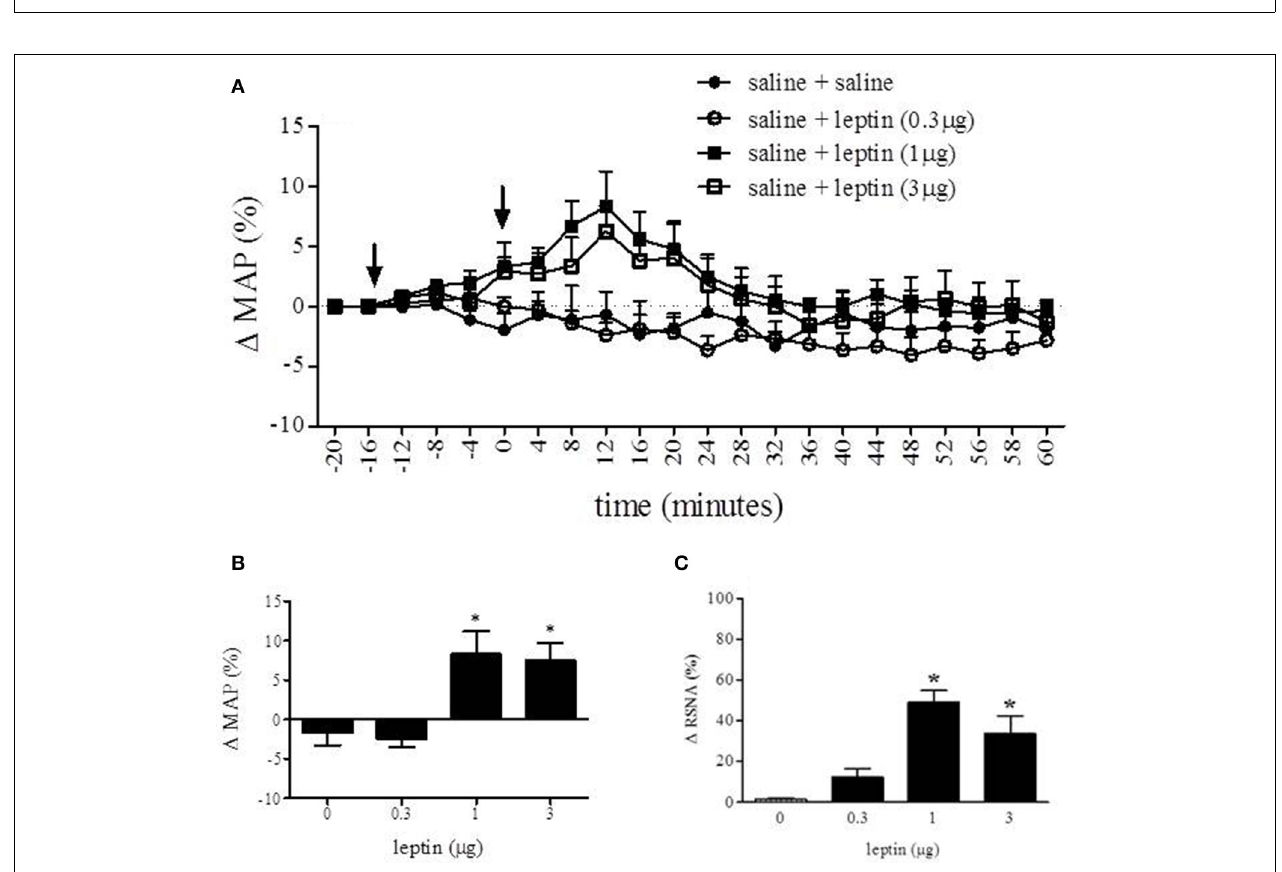
FIGURE 3 | Histological and physiological verification of RVLM injection site. A subset of animals received Chicago Blue injection at the end of the glutamate identification procedure to verify histological placement of pipette. Coronal sections through the hindbrain were used to identify the injection